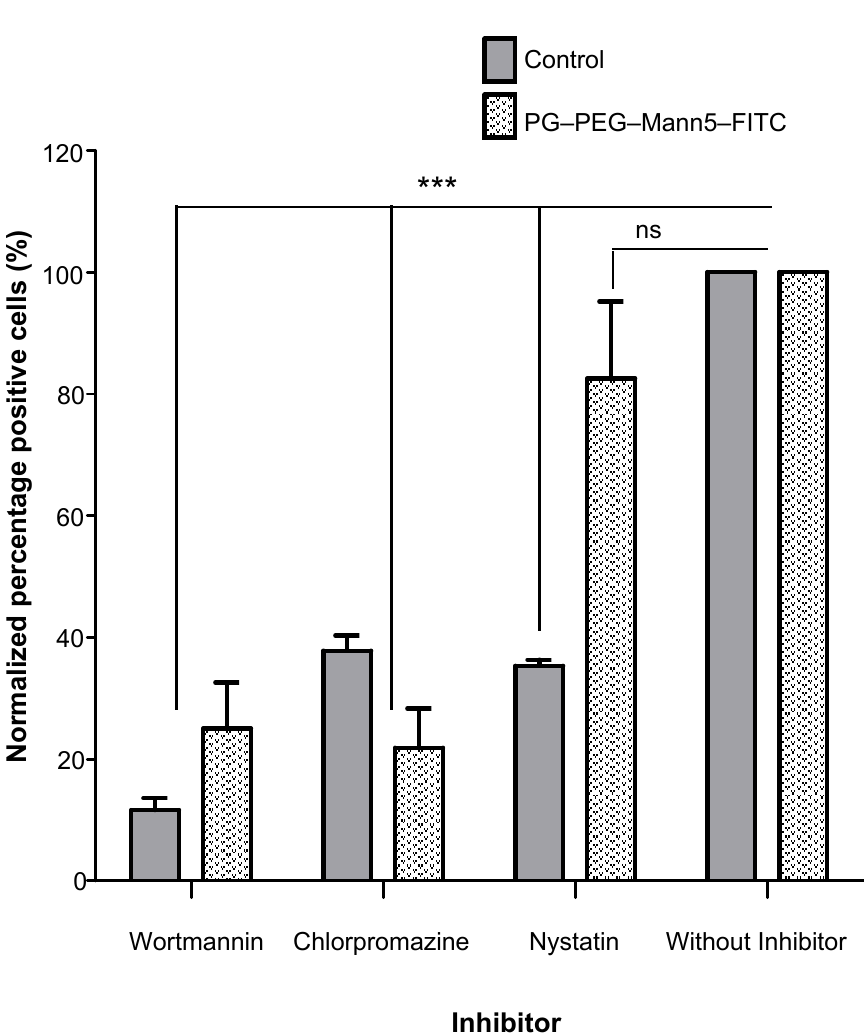
Figure 4. Effects of different pharmacological inhibitors on the uptake of PG–PEG–Mann5–FITC. RAW 264.7 macrophages were preincubated for different times with inhibitors, treated with PG–PEGMann5–FITC for 24 h and then fixed and analyzed by flow cytometry. Results are reported as the percentage of uptake relative to untreated cells exposed to NPs (set to 100%). As positive controls were used FluoSphere (1.0 µm), Transferrin and cholera toxin subunit-B (gray boxes). Values are expressed as normalized percentage of positive cells ± SD of three independent duplicate experiments. Black asterisks indicate p values for t -Student’s test. Comparisons between cells treated with endocytic inhibitors and untreated cells (*** p < 0.001).